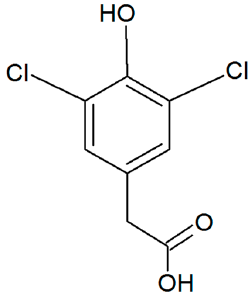
Figure 3. Structure of the immunizing TCA hapten C (modified from [66]).